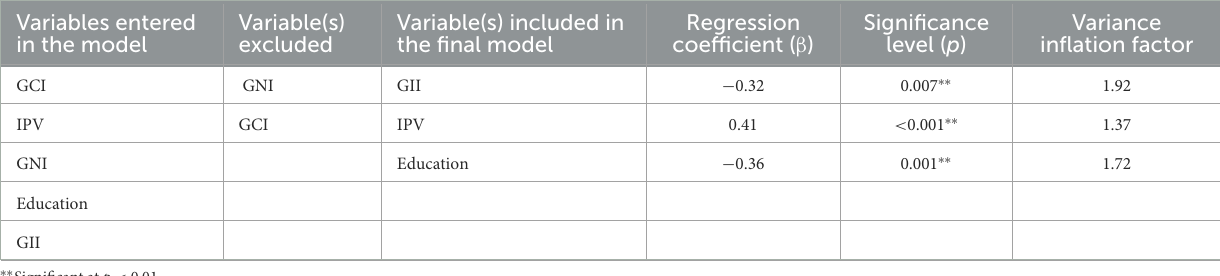
TABLE 4 Multivariate linear regression analyses of the variables associated with depression in